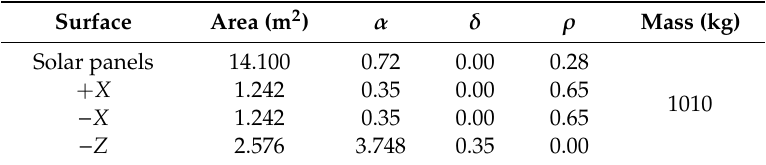
Table 3. Initial optical properties and areas of the BeiDou-3 satellites, made by Shanghai Engineering Center for Microsatellites (SECM).